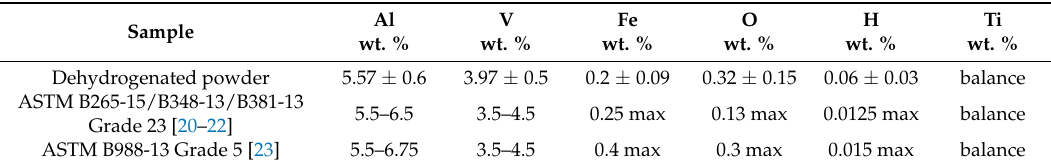
Table 1. Elemental analysis of dehydrogenated powder and relevant standards.